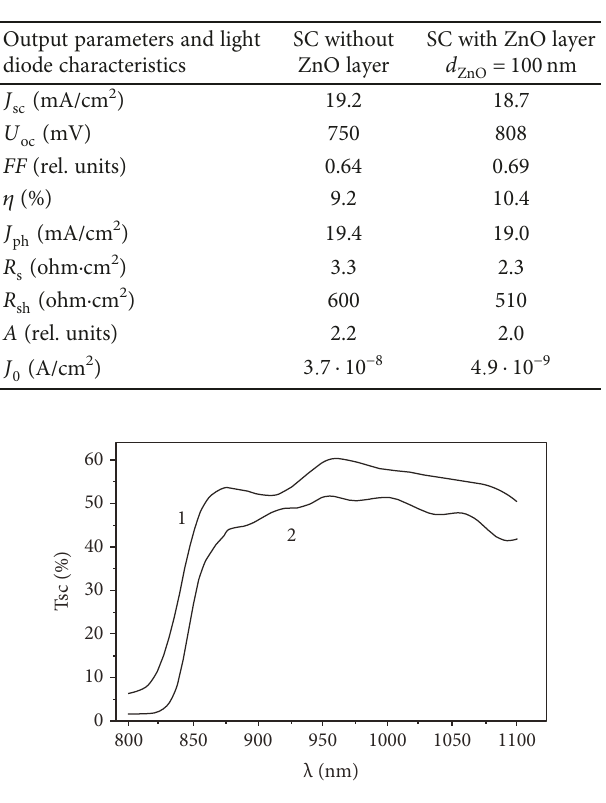
Figure 3: Light current-voltage characteristics of fl exiblepolyimide/ ITO/CdS/CdTe/Cu/ITO solar cell (1) and fl exible polyimide/ITO/ ZnO/CdS/CdTe/Cu/ITO solar cell (2). Table 4: Output parameters and light diode characteristics of fl exible polyimide/ITO/ZnO/CdS/CdTe/Cu/ITO solar cells under illumination from the front side.